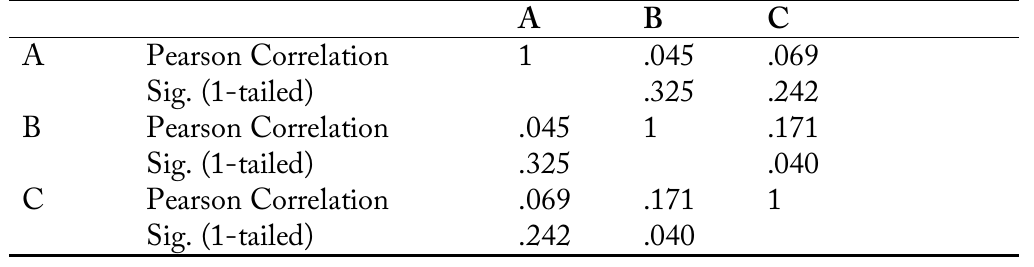
Table 3: Summary of the correlation analysis of each